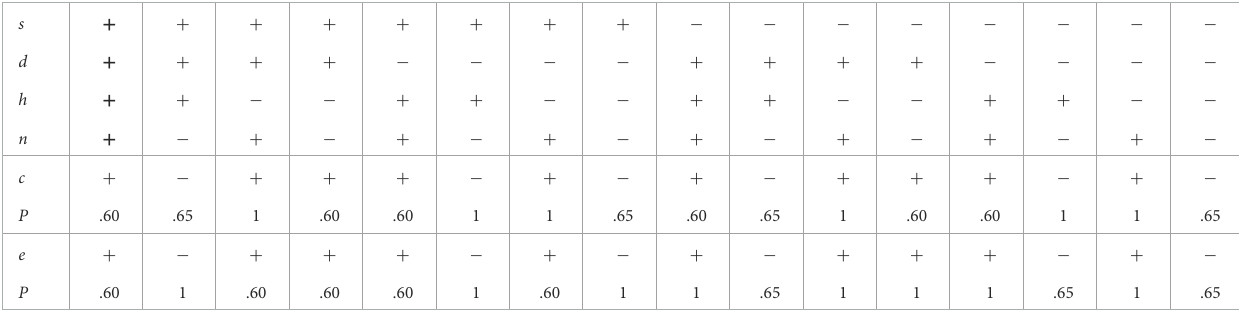
TABLE 1 An example of probabilistic classifier with X ={ s , d , h , n } and C ={ c , e } .